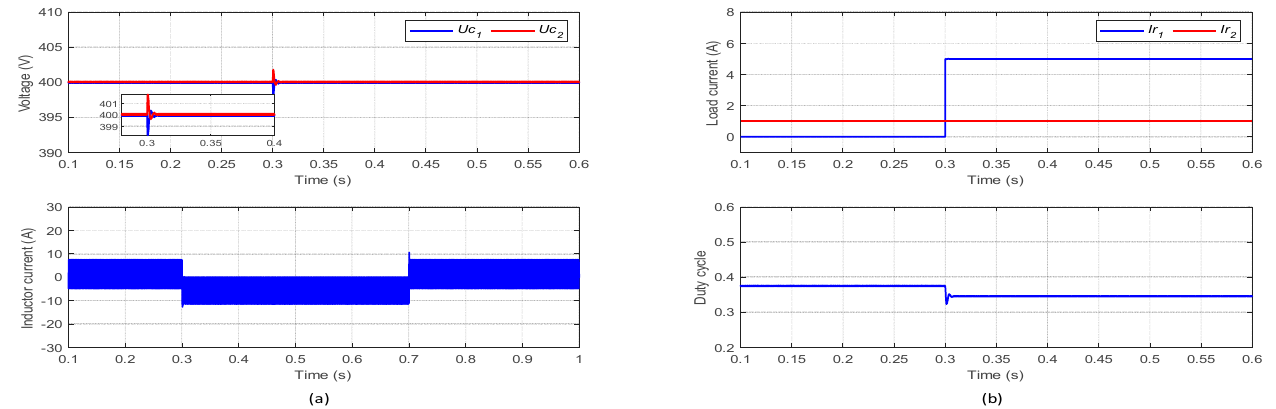
Figure 13. Numerical results with 50% inductance nominal value using the GA – PI controller. ( a ) Inductor current and output voltages. ( b ) Duty cycle and load current.